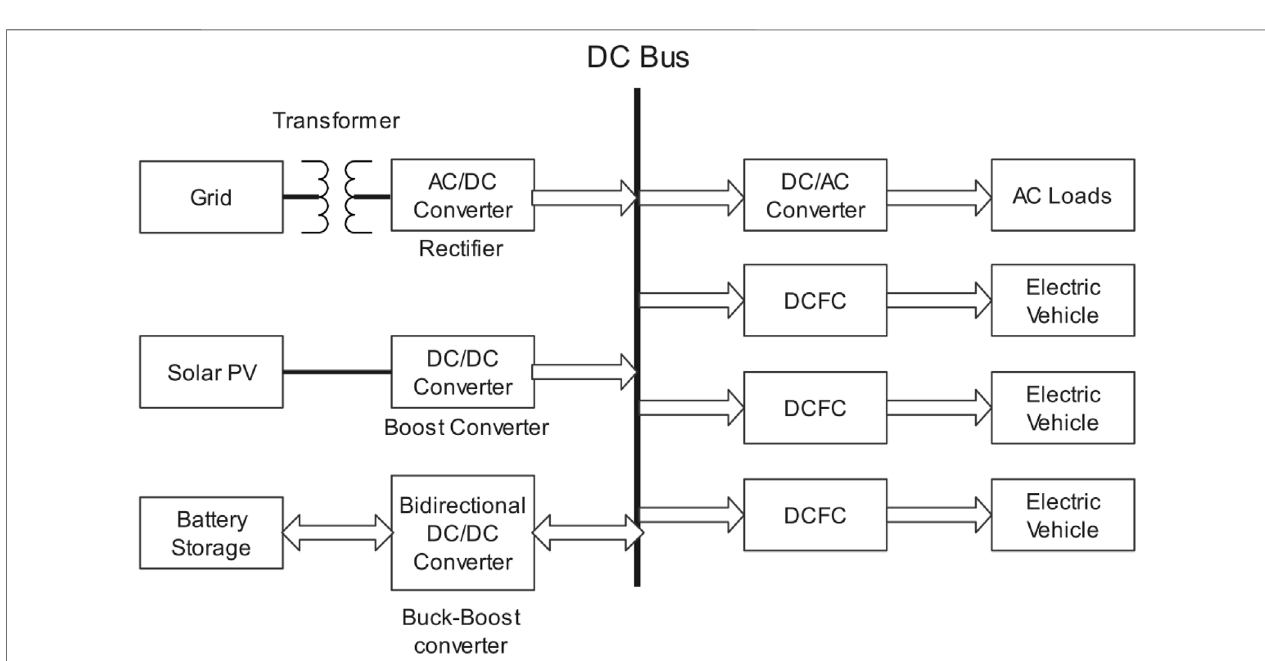
FIGURE 2 | DC micro-grid for EV charging